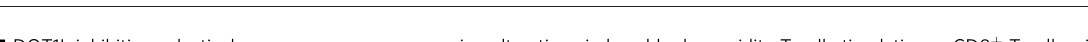
Fig. 5 DOT1L inhibition selectively suppresses gene expression alterations induced by low-avidity T-cell stimulation. a CD8 + T cells with high avidity (DMF5) and low avidity (clone 413) for A2/MART1 were stimulated with aAPC/A2 loaded with 10 μ g/ml heteroclitic A2/MART1 27 – 35 peptide with or without SGC0946 treatment. The mean fl uorescence intensity of pERK within the CD8 + T-cell population at the indicated time points is shown ( n = 4 different donor samples, paired two-sided t -test). b – e The DMF5- or clone 413 TCR-transduced CD8 + T cells were treated with SGC0946 or DMSO and stimulated for 24 h with aAPC/A2 loaded with 10 μ g/ml heteroclitic A2/MART1 27 – 35 peptide. Gene expression pro fi les of the stimulated T cells